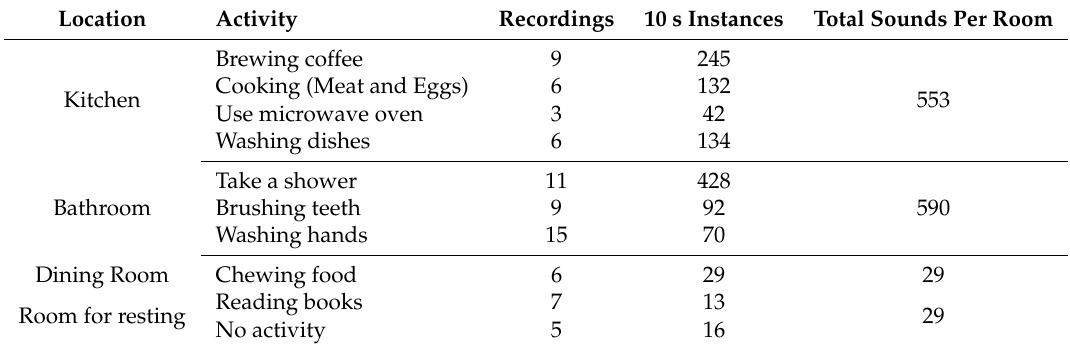
Table 5. Number of recordings and 10 s instances per room described by contextual activity recognition